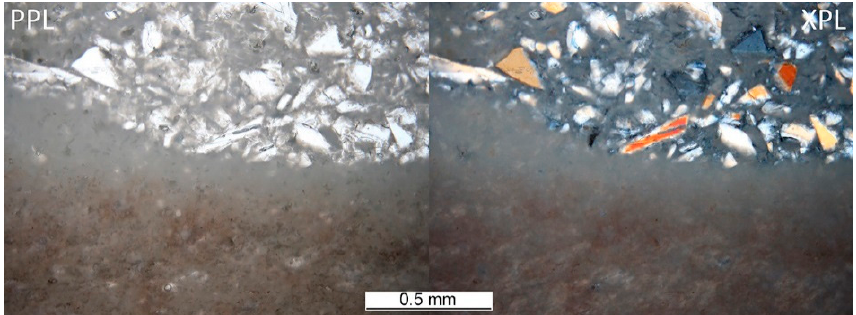
Figure 3. Sample K-T–fired clay nodules surrounded by mixture of fired clay and mullite; PPL = plane polarized light, XPL = crossed polarized light.